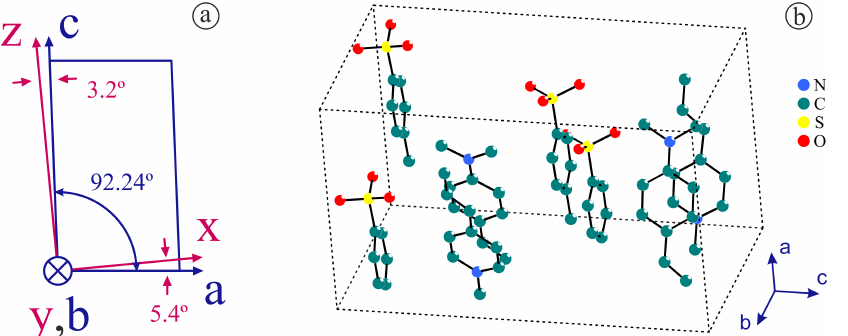
Figure 7. ( a ) Assignment of crystallographic and principal dielectric axes of the monoclinic formation of DAST; ( b ) Crystal structure of DAST (the .cif files taken from the CCDC database can be found in the Supplementary Materials).